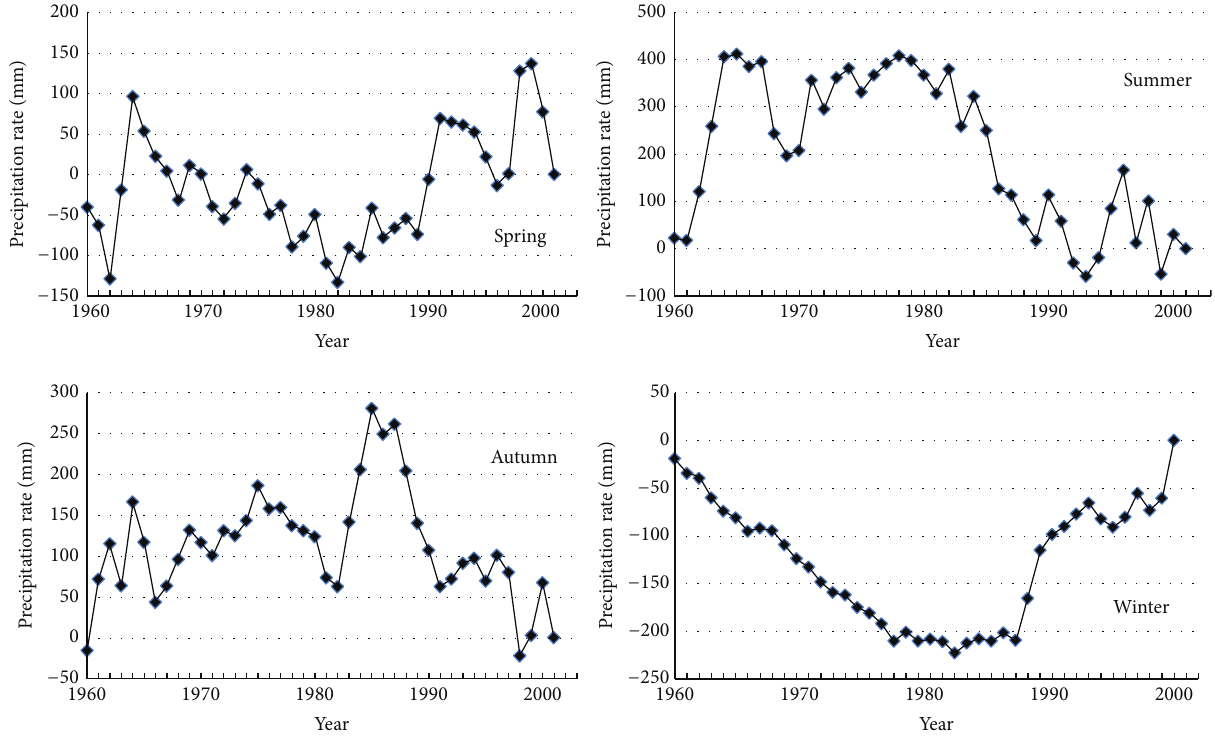
Figure 9: Cumulative precipitation rate anomalies in all seasons in the Lower Yellow River Region from 1960 to